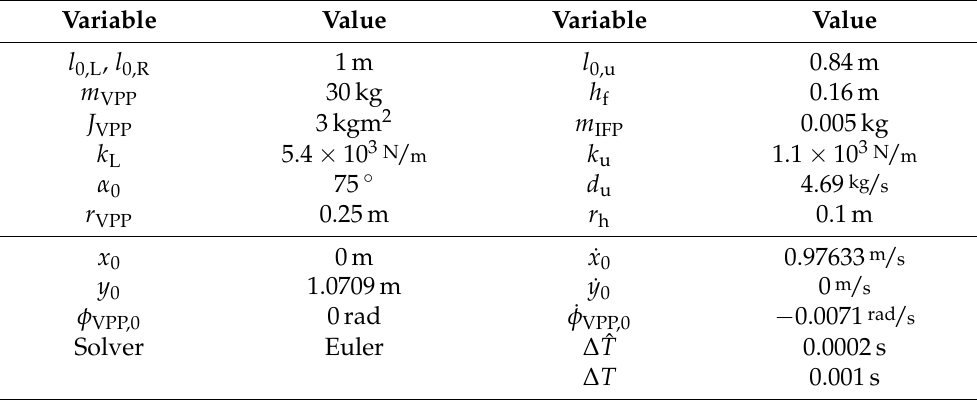
Table 1. Parameters and initial conditions used in the HiL